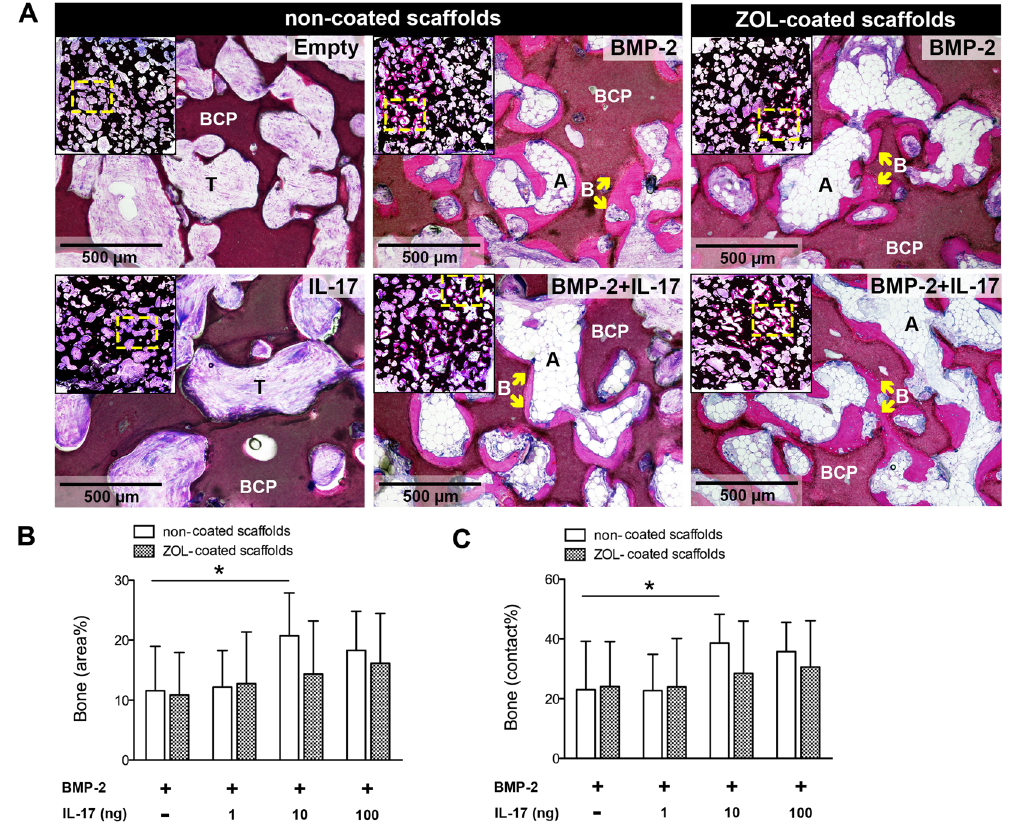
Figure 8. Bone formation in scaffolds with suboptimal BMP-2 dose after 12-week implantation ( A ) Methylene blue/basic fuchsin staining of bone ( B , pink), with the scaffold overview in insets ( B , C ) Quantification of bone formation as bone area% ( B ) and bone contact% ( C ). Data are represented as the mean ± SD (n = 8). * p < 0.05. BCP, biphasic calcium phosphate; A, adipose tissue; T, connective